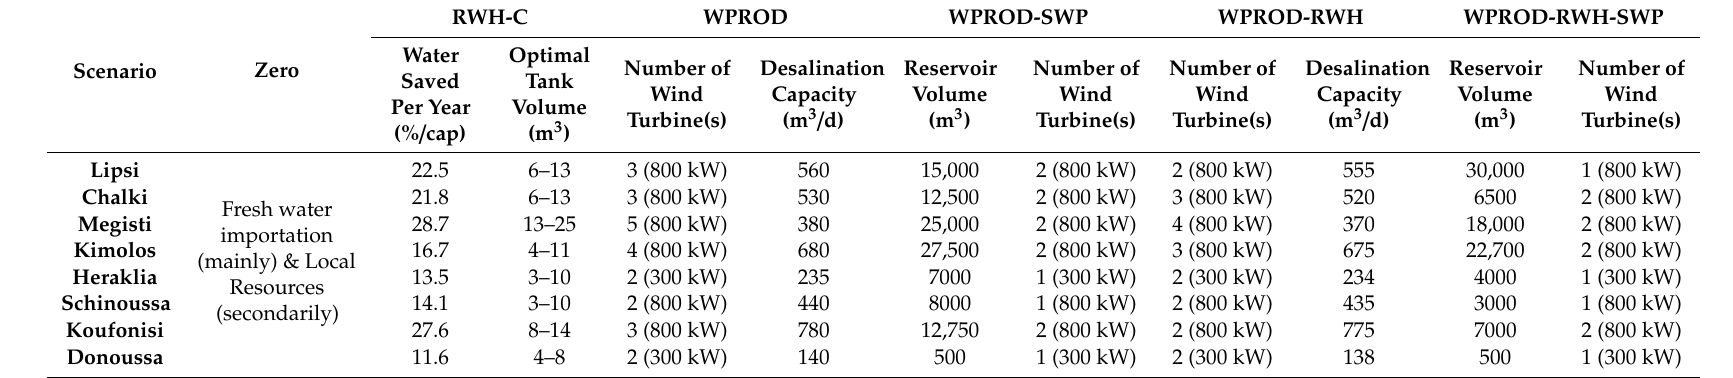
Table 5. Design parameters for each